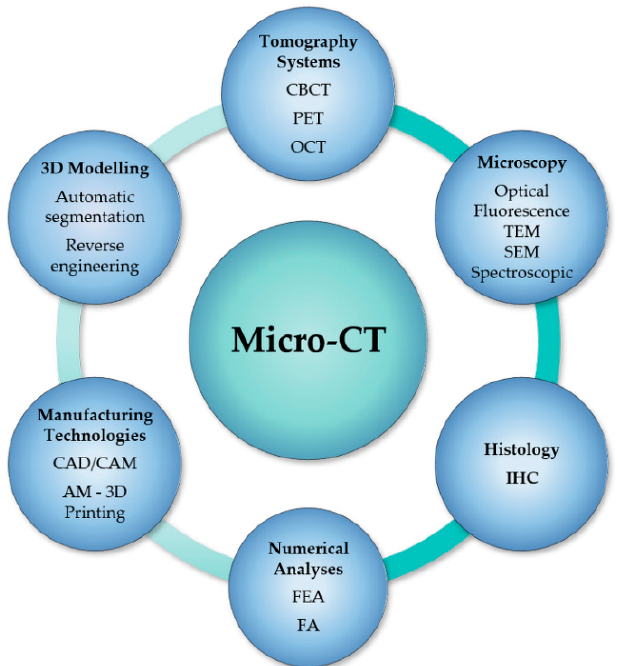
Figure 2. Main techniques and technologies applied with the micro-computed tomography (micro-CT) in the collected studies.